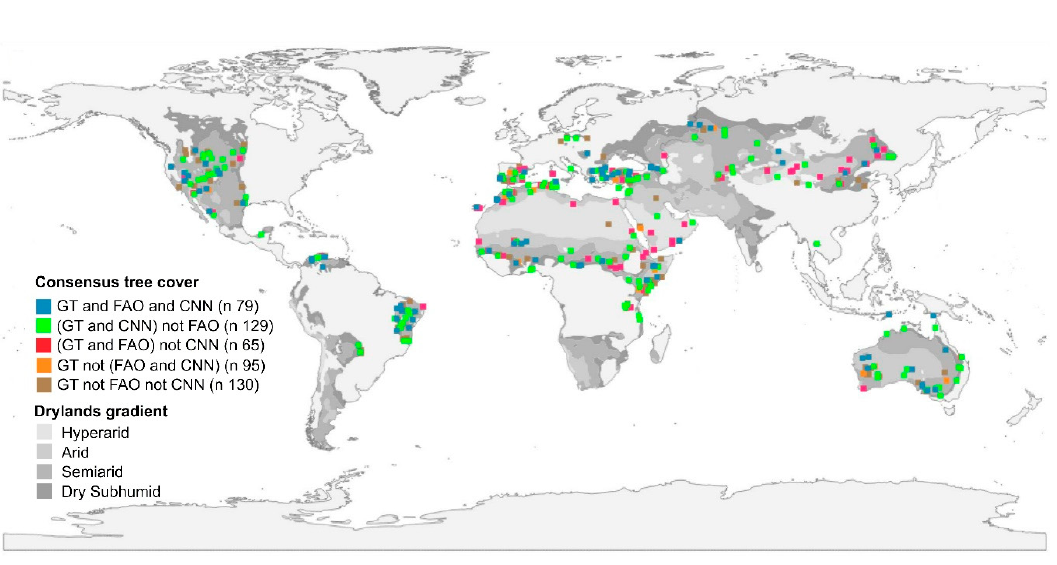
Figure 4. Consensus on tree cover results between FAO’s Global Dryland Assessment in Bastin et al. [19], our CNN-based method, and ground truth (GT). Blue, green, red, orange, and brown for GT and FAO and CNN, (GT and CNN) not FAO, (GT and FAO) not CNN, GT not (FAO and CNN), and GT not FAO not CNN, respectively. Drylands aridity map from UN Environment Programme World Conservation Monitoring Centre UNEP-WCMC: Hyperarid (Aridity Index AI < 0.05), arid (0.05 ≤ AI < 0.2), semiarid (0.2 ≤ AI < 0.5), and dry subhumid (0.5 ≤ AI < 0.65).